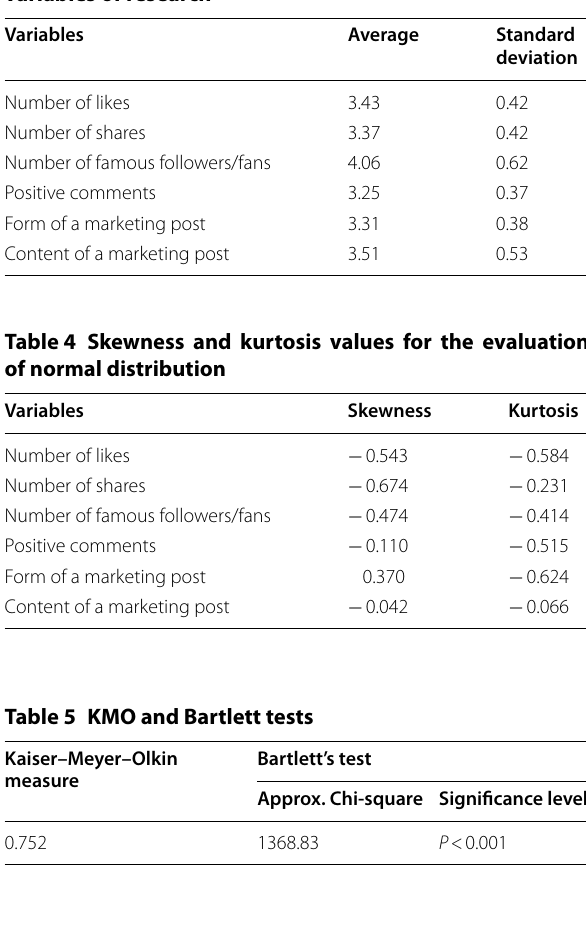
Table 3 Average and standard deviation of the main